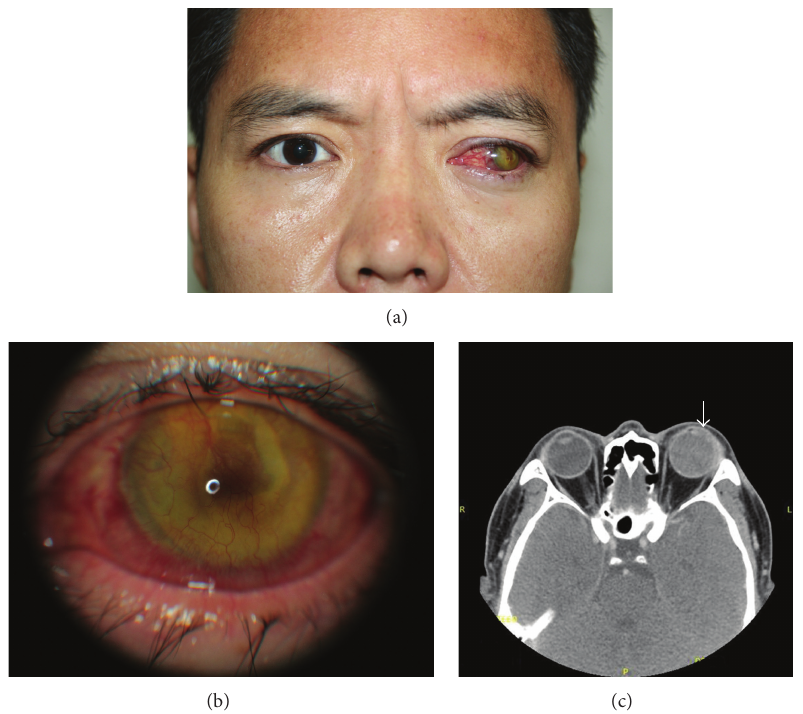
Figure 1: (a) Photograph taken at initial visit showing laterally deviated left eye. Conjunctival injection, corneal opacity, and yellowish pigments behind the cornea are observed. (b) Slit-lamp microscopy examination at initial visit showing corneal neovascularization and an amorphous yellowish lens material with a reddish central pit. (c) Orbital computed tomography scan (axial) at initial visit showing a laterally deviated left eyeball filled with slightly brighter intraocular contents than thecontralateral eye. Arrows indicate that the lens material is pushed against the cornea so as to nearly collapse the anterior chamber.